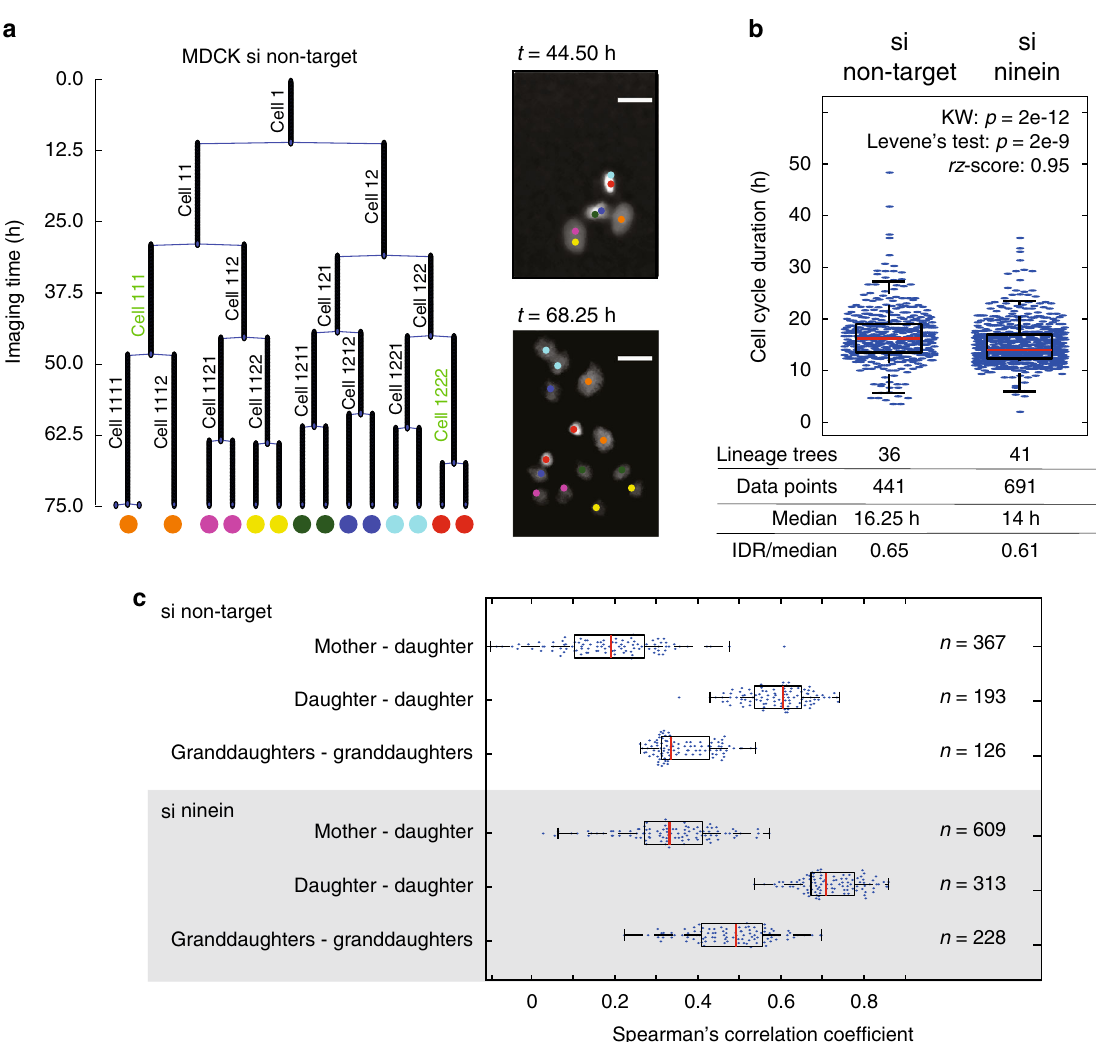
Fig. 1 Variability of cell cycle duration is higher in si non-target MDCK cells than in si ninein-treated MDCK cells. a Left: tracked imaged lifetimes of cells with indicated cell identities (vertical terms), originating from a single cell over 75 h represented in a lineage tree (lineage identi fi er (ID) 10). Nodes depict cell divisions, edge length reports tracked imaged lifetimes of bijectively assigned cell identities (cell ID), which corresponds to cell cycle durations of these cells if the cell could be imaged over its entire lifetime. Green cell IDs indicate L-cells of the 3:L motif. Colour circles represent cell identi fi ers at imaging end. Right: fl uorescence images of nuclei superimposed with colour circles at indicated time points of the lineage tree (e.g., blue and red cells — colour code tree imaging end). Bars 5 µ m. b Distributions of cell cycle durations in si non-target and si ninein MDCK cells. Boxplot: central mark — median; edges of horizontal box — fi rst and third quartiles; whiskers — 1.5 times the interquartile range (IQR). Below: lineage trees — number of analysed lineage trees; data points (blue) — number of cell cycle durations; median — median cell cycle duration (red); IDR/median — interdecile range normalised to the median as quanti fi er for dispersion; p -values for Kruskall – Wallis (KW) and Levene ’ s test; rz-score — robust z-score. c Spearman ’ s correlation coef fi cients of cell cycle durations for all possible mother – daughter, daughter – daughter or granddaughter – granddaughter pairs of cells in si non-target and si ninein-treated cells. Boxplots (as in b ) show the distributions of Spearman ’ s correlation coef fi cients of 100 times randomly chosen cell pairs of the indicated types to compare the two conditions; individual data points after subsampling (blue circles). n number of mentioned cell pairs in the given data set that were